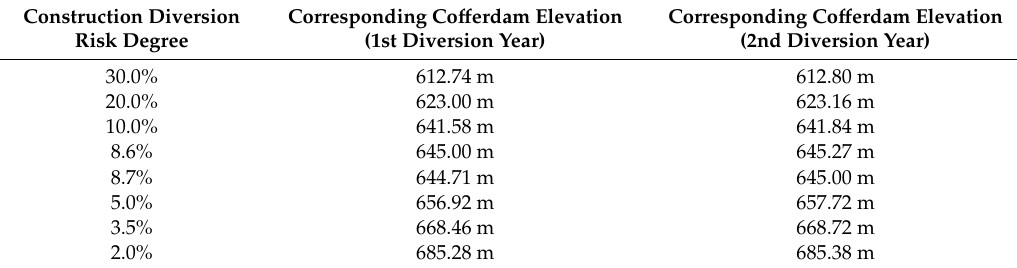
Table 3. Construction Diversion Risk assessment